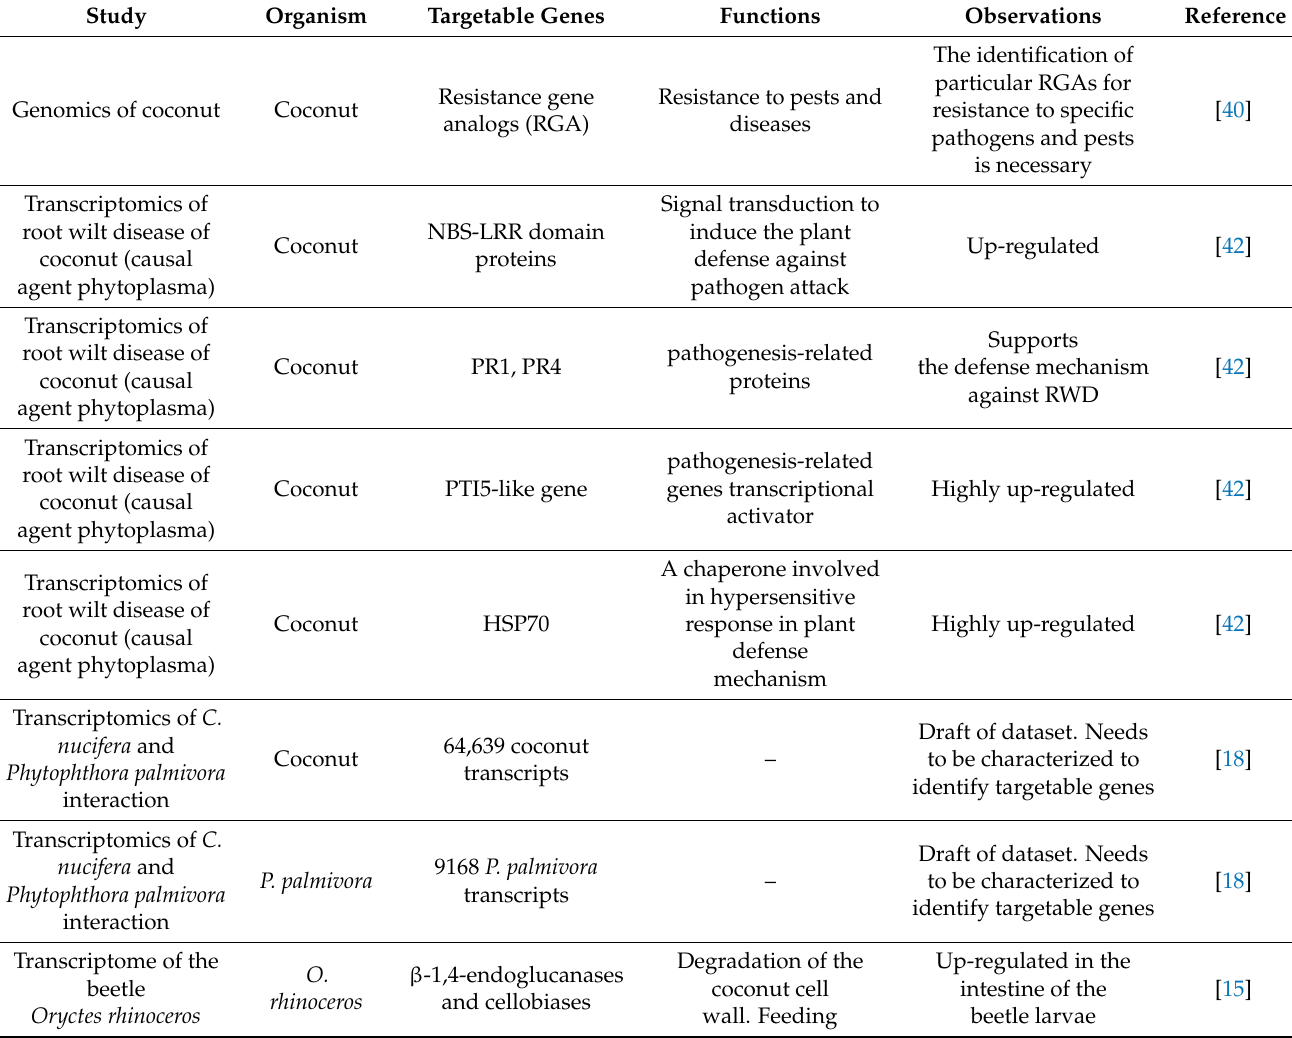
Table 1. Targetable genes in coconut or its pathogens/pests identified by omics